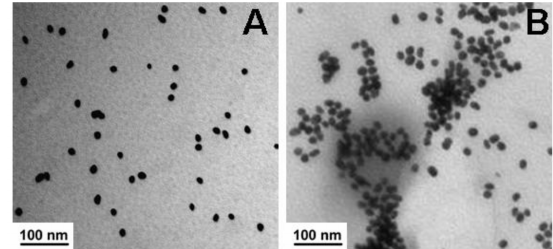
Figure 5. TEM images of PLL-AuNPs under pH = 2.0 ( A ) and pH = 12.0 ( B